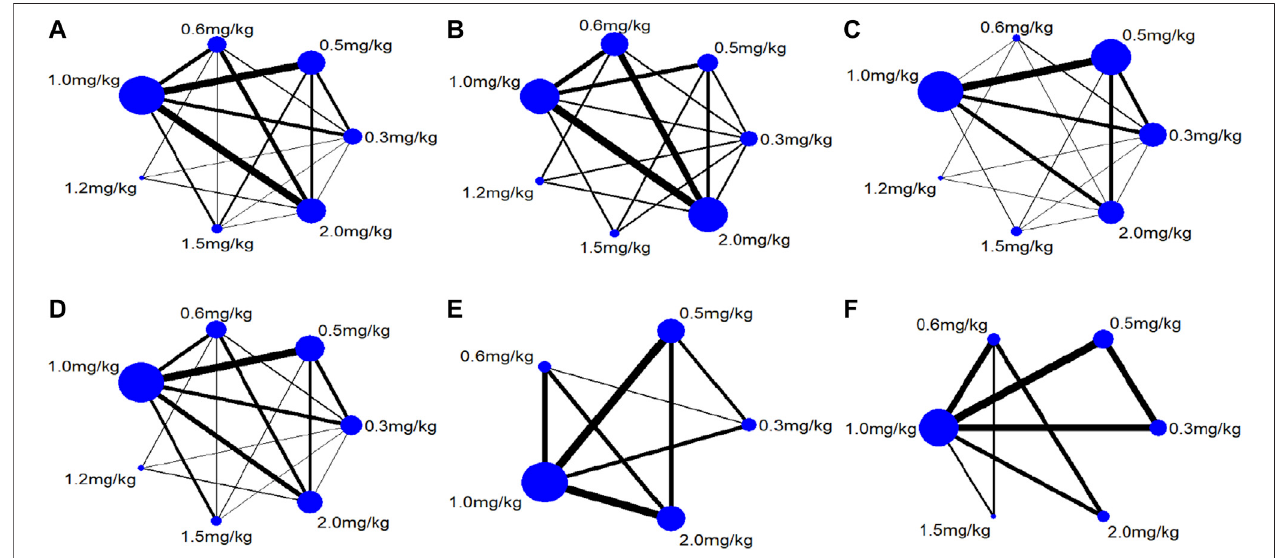
FIGURE 3 | Relations diagram of different dose sildena fi l for PPNN.